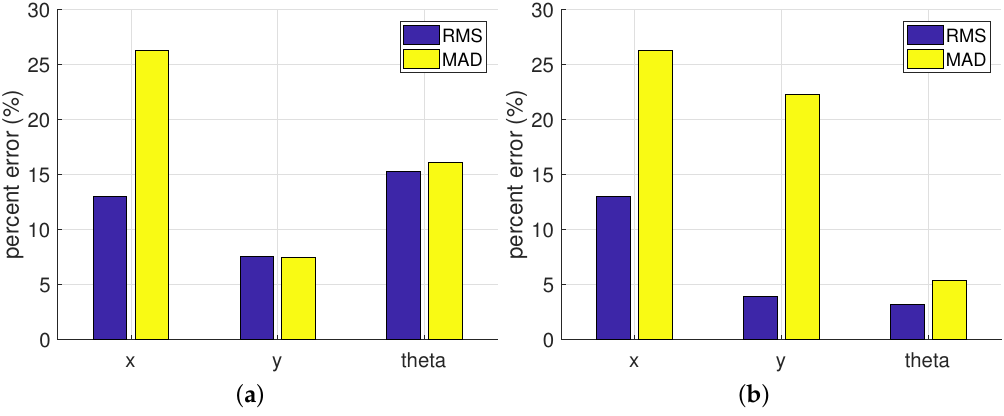
Figure 17. RMS and MAD percent errors results for the trapezoidal trajectory with offsets. The percent errors x, y and theta were computed based on the RMS and MAD results of the mobile robot error pose x e , y e and θ e , respectively. ( a ) Percent error for EKF-SNPID vs PID. ( b ) Percent error for EKF-SNPID vs. PID with